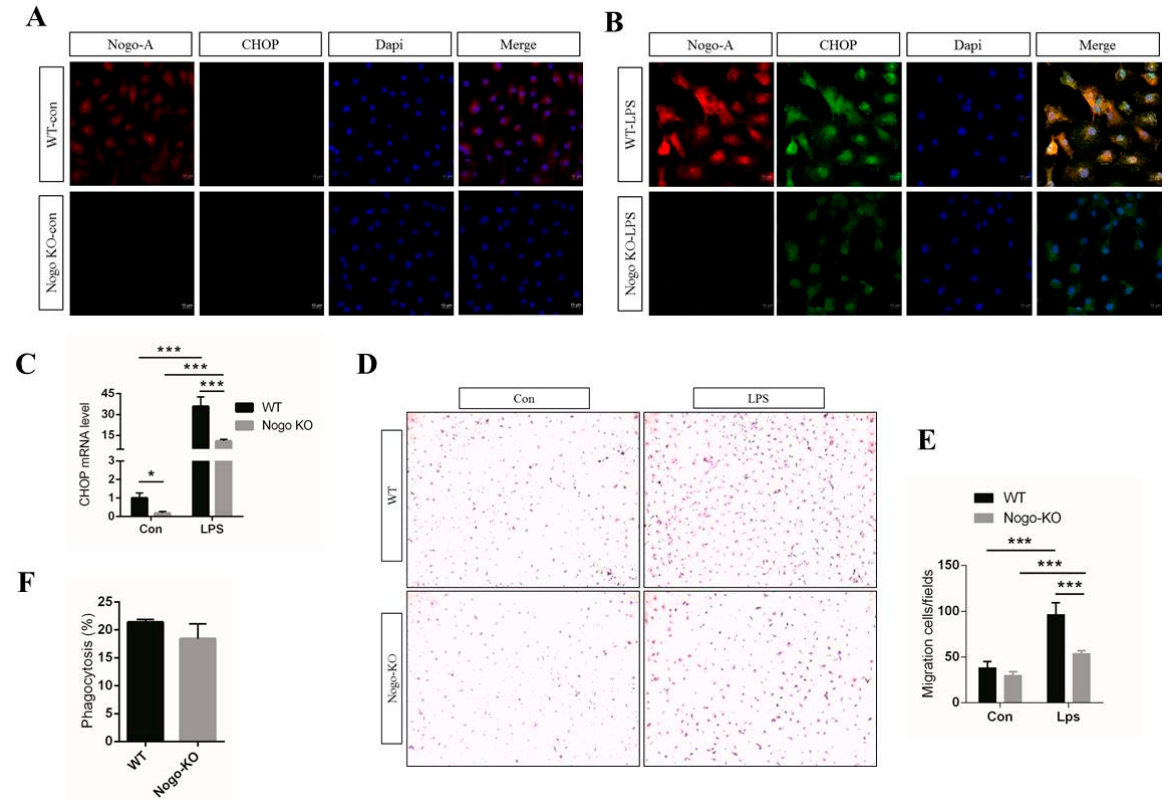
Figure 3. Nogo deficiency inhibits CHOP signaling and migration of BMDM after LPS treatment. ( A ) IF results of Nogo-A and CHOP in control WT BMDM and Nogo-KO BMDM ( n = 3). Nogo-A is expressed in control WT BMDM, while CHOP expression is absent in control WT and Nogo-KO BMDM. ( B ) IF results show that Nogo-A (red) and CHOP (green) are increased in LPS-treated WT BMDM compared with the levels in Nogo-KO BMDM. ( C ) Level of CHOP mRNA is upregulated in LPS-treated WT BMDM compared with LPS-treated Nogo-KO BMDM ( n = 4). ( D ) Migration assay using WT and Nogo-KO BMDM ( n = 3). Nogo-KO BMDM exhibit a lower migration ability compared with WT BMDM after LPS treatment (100 ng/mL) for 24 h. ( E ) Quantification of BMDM migration reveals a significantly lower migration ability in LPS-treated Nogo-KO MMDM compared with WT BMDM ( n = 3). No significant difference was observed in migration activity between control WT and Nogo-KO BMDM. ( F) Phagocytosis by macrophages from WT and Nogo-KO BMDM after treatment with fluorescent bioparticles of the pro-inflammatory cytokine inducer zymosan ( n = 3). The numbers of phagocytes were analyzed by flow cytometry. Data are shown as the mean ± standard error of the mean. Statistical significance was determined using Student’s t -test. Data are denoted by asterisks, where * p < 0.05, ** p < 0.01, and *** p < 0.001. Alexa Fluor (AF)-555 and AF-488 were used as secondary antibodies. Scale bar, 10 μ m, 400× magnification.